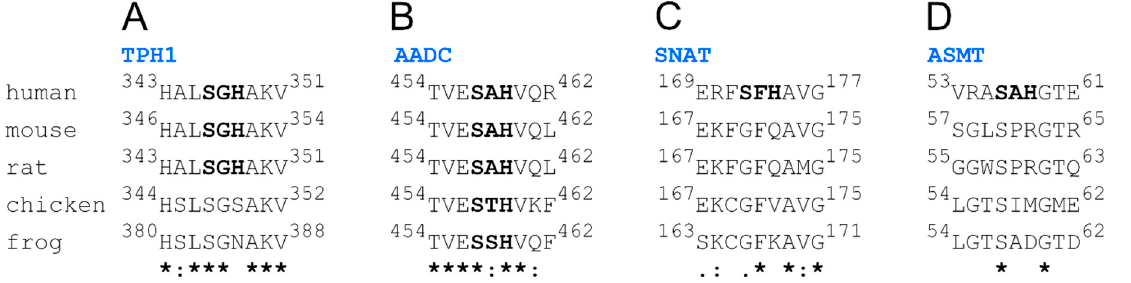
Figure 2. Multiple alignments of nine-amino-acid fragments homologous to human TPH1 ( A ), AADC ( B ), SNAT ( C ), and ASMT ( D ) parts with the Ser-Xaa-His sequences.